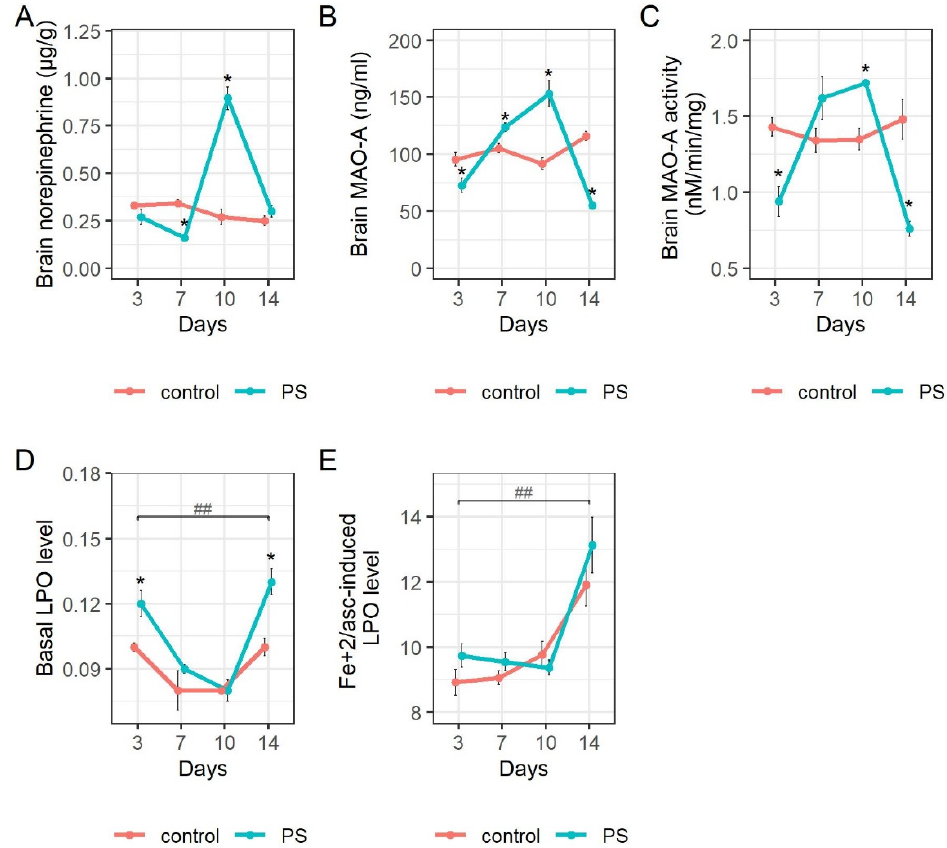
Figure 4. The impact of post-stress time on brain norepinephrine concentration, MAO-A protein concentration and activity, and LPO levels. Mann–Whitney comparisons of M ± SD for ( A ) brain norepinephrine concentration, ( B ) brain MAO-A concentration, ( C ) brain MAO activity, ( D ) basal LPO content, ( E ) Fe 2+ /ascorbate induced LPO content. * p < 0.05 for differences between means of respective control and PS groups. ## p < 0.01 for differences between means of PS group at post-stress days 3 and 14.